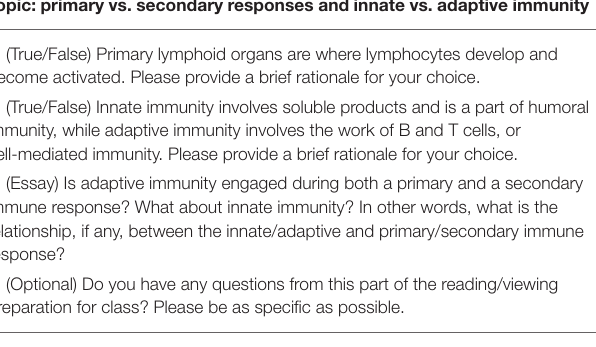
TABLE 1 | Examples of pre-class questions for just-in-time-teaching. Topic: primary vs. secondary responses and innate vs. adaptive